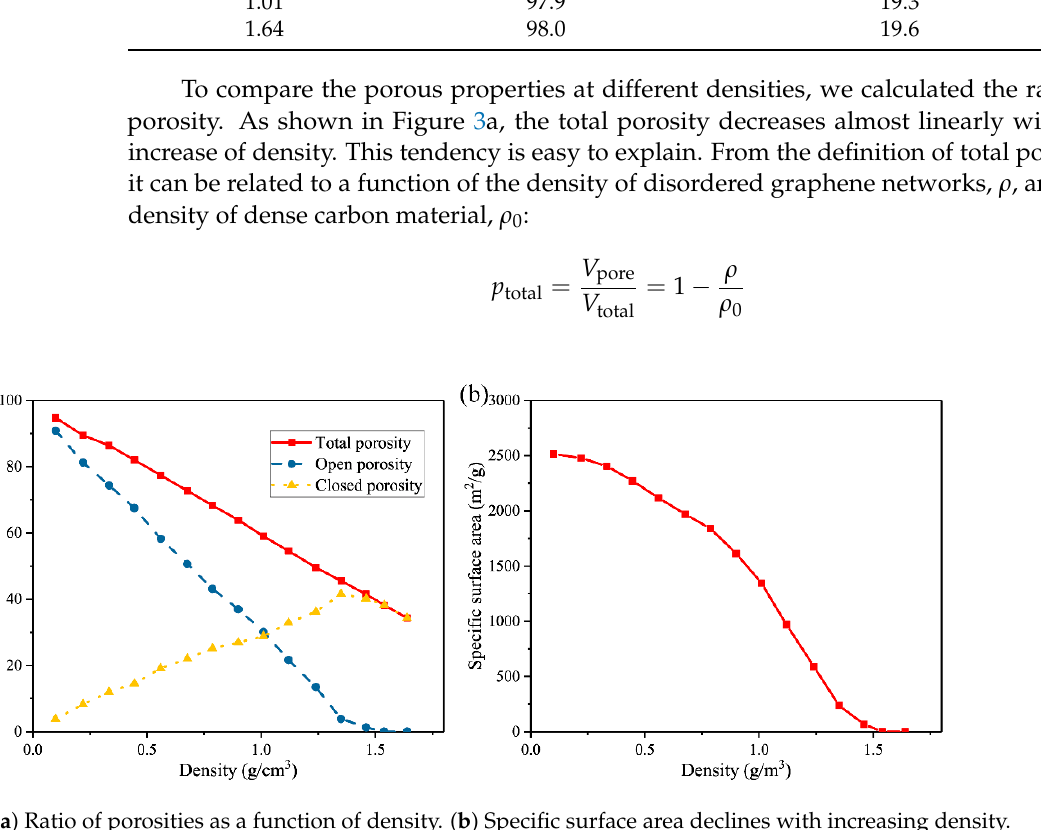
Figure 3. ( a ) Ratio of porosities as a function of density. ( b ) Specific surface area declines with increasing density.